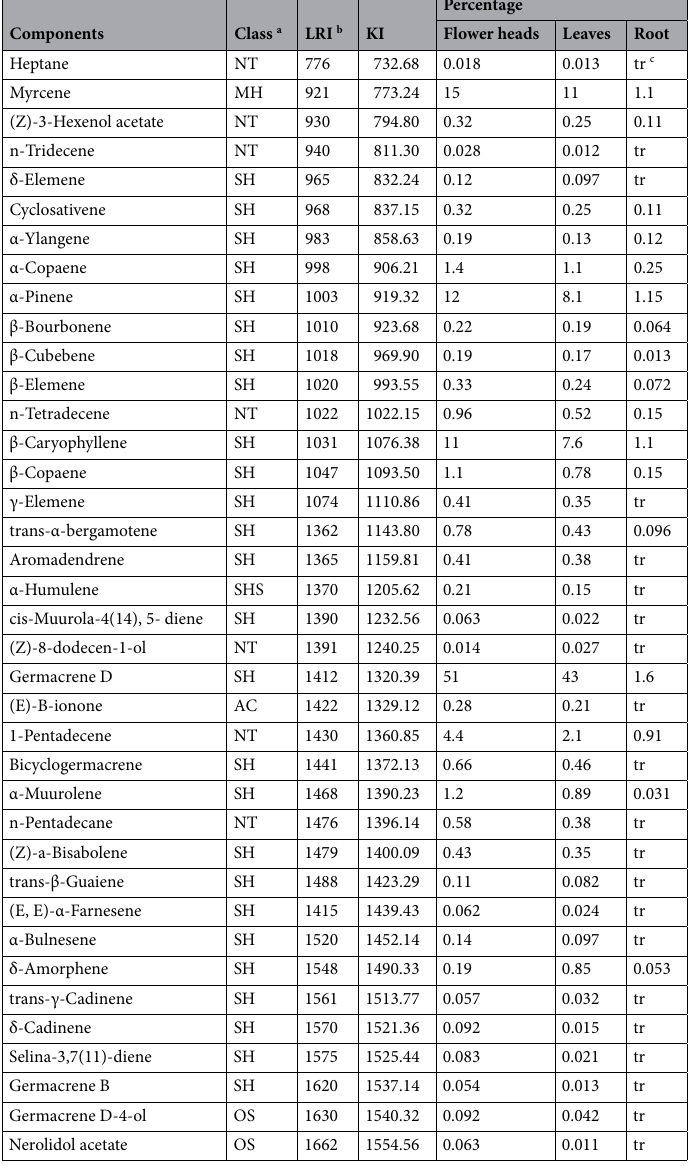
Table 3. Essential oil chemical composition of E.purpurea grown at the best growing media at 90:10 NO 3- / NH 4+ ratio. a Class: AC apocarotenoids; MH monoterpene hydrocarbons; SH sesquiterpene hydrocarbons; NT non-terpenes; OS oxygenated sesquiterpenes. b LRI Linear Retention Index. c Trace (below 0.01%); KI Kovats